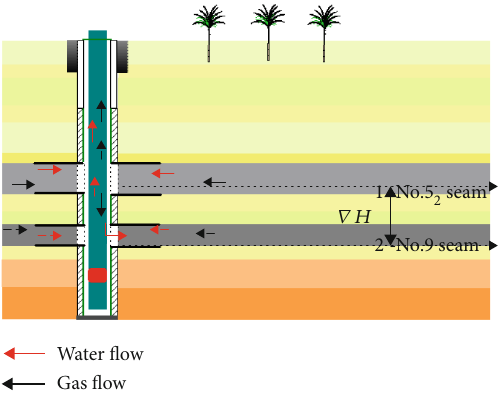
Figure 6: Schematic for multicoal seam development of TS-1